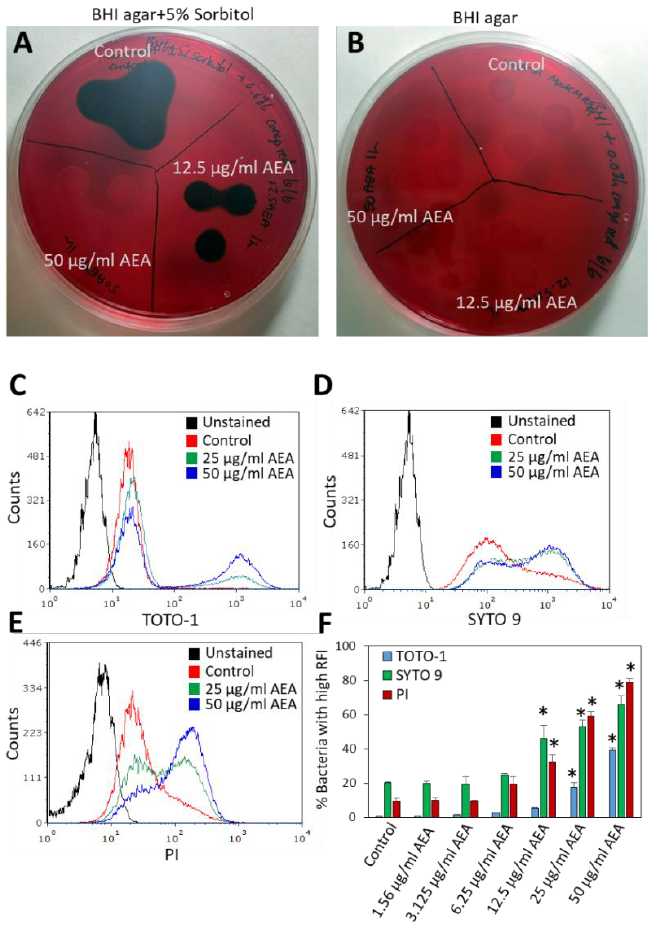
Figure 5. AEA prevents the secretion of exopolysaccharides (EPS) and increases extracellular DNA (eDNA) production. ( A , B ). MDRSA CI-M was incubated in the absence or presence of 12.5 µg/mL or 50 µg/mL AEA for 1 h, and then 10 µL of each triplicate were placed on Congo Red agar plates containing 5% sorbitol ( A ) or plain Congo red plates ( B ). ( C , E ). MDRSA CI-M was incubated in the absence or presence of 12.5 µg/mL or 50 µg/mL AEA for 2 h, and then stained with 2 μM TOTO-1 ( C ), 2 μM SYTO 9 ( D ), or 2 μg/mL PI ( E ) for 20 min and analyzed by flow cytometry. ( F ). The percentage of bacteria with high relative fluorescence intensity (RFI) of samples presented in ( C , E ). * p < 0.05 when comparing the AEA-treated bacteria with control bacteria.